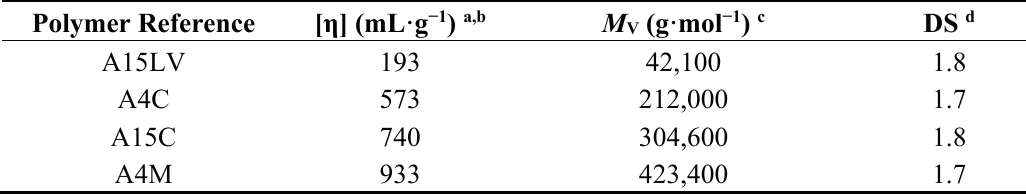
Table 1. Methylcellulose